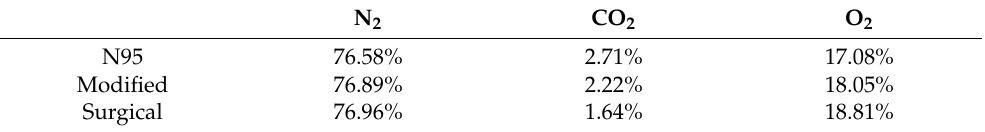
Table 4. N 2 , CO 2 , and O 2 concentrations inside three face masks measured by a gas chromatography.